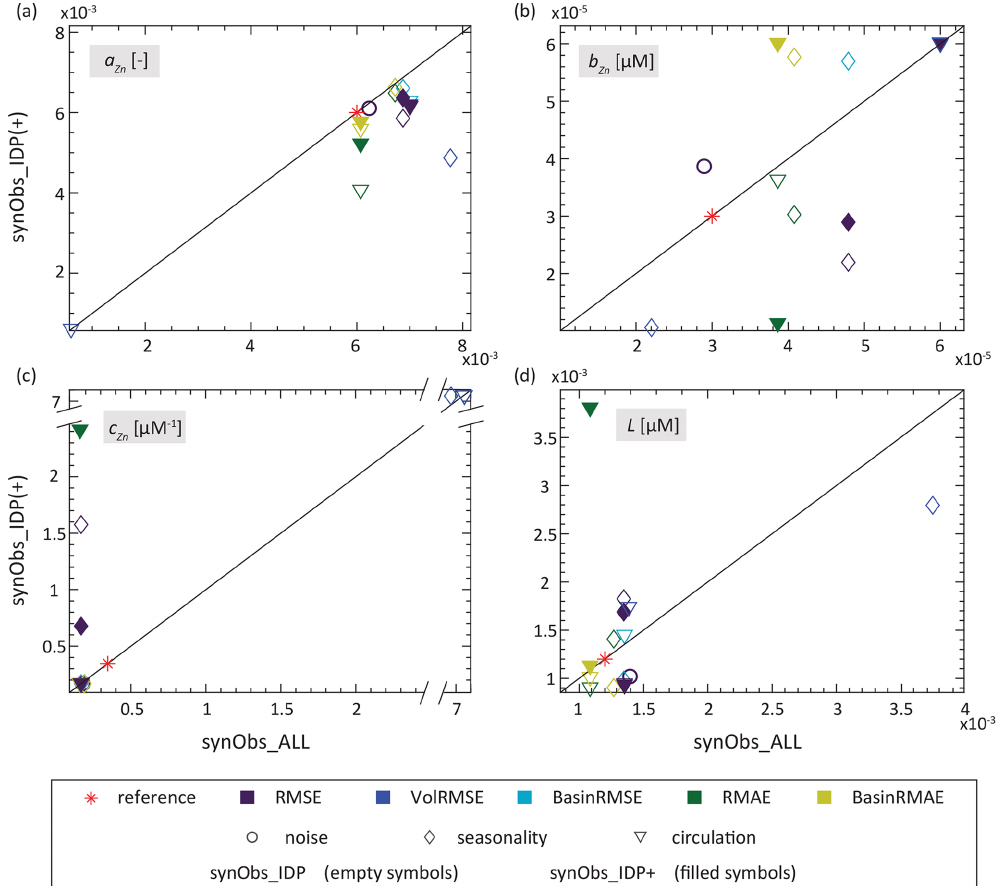
Figure 9. Comparison of parameter values obtained in synObs_IDP (empty symbols) or synObs_IDP + (filled symbols) with those from the corresponding synObs_ALL experiment. Symbols indicate the experiment